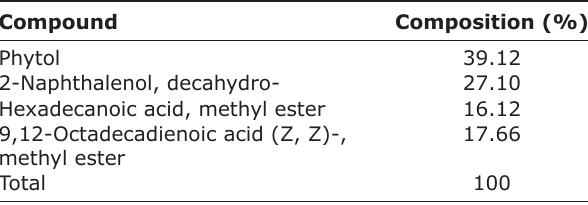
Table-2: Compound composition of P. pellucida leaf